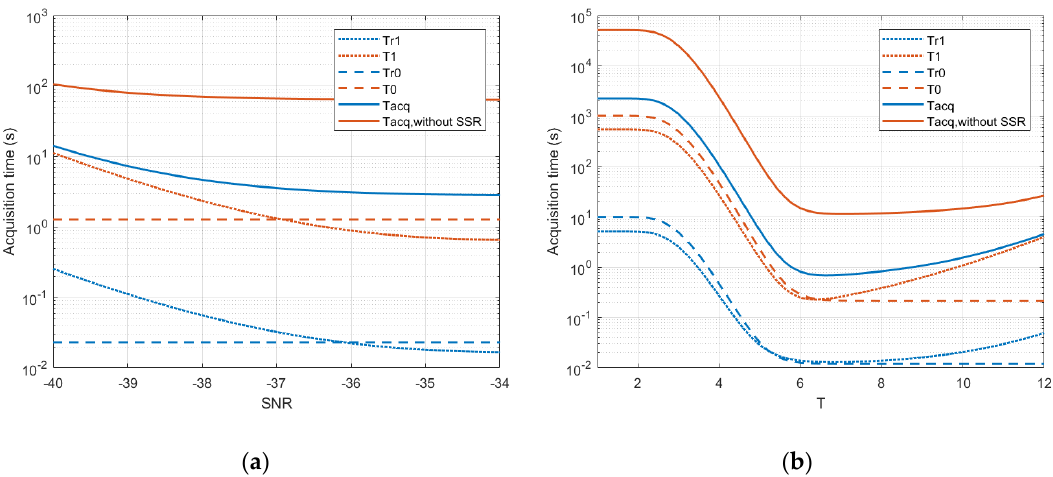
Figure 16. ( a ) Acquisition time versus SNR ( P fa = 0.001); ( b ) acquisition time versus multiple parameter T (SNR = − 36 dB).